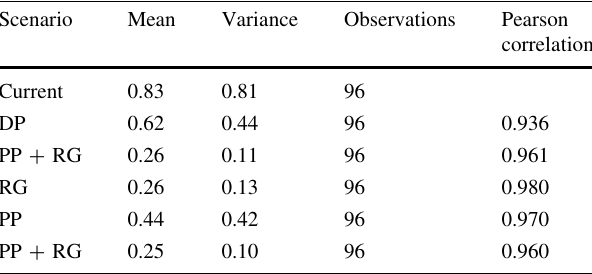
Table 5 Summary t test: paired two sample for means current and GI Scenario